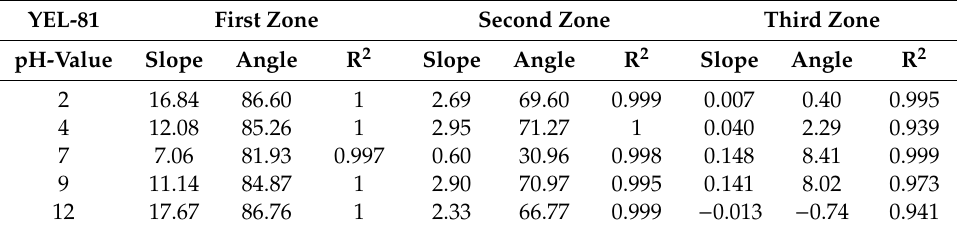
Table 2. Return of Weber and Morris models for Reactive Yellow